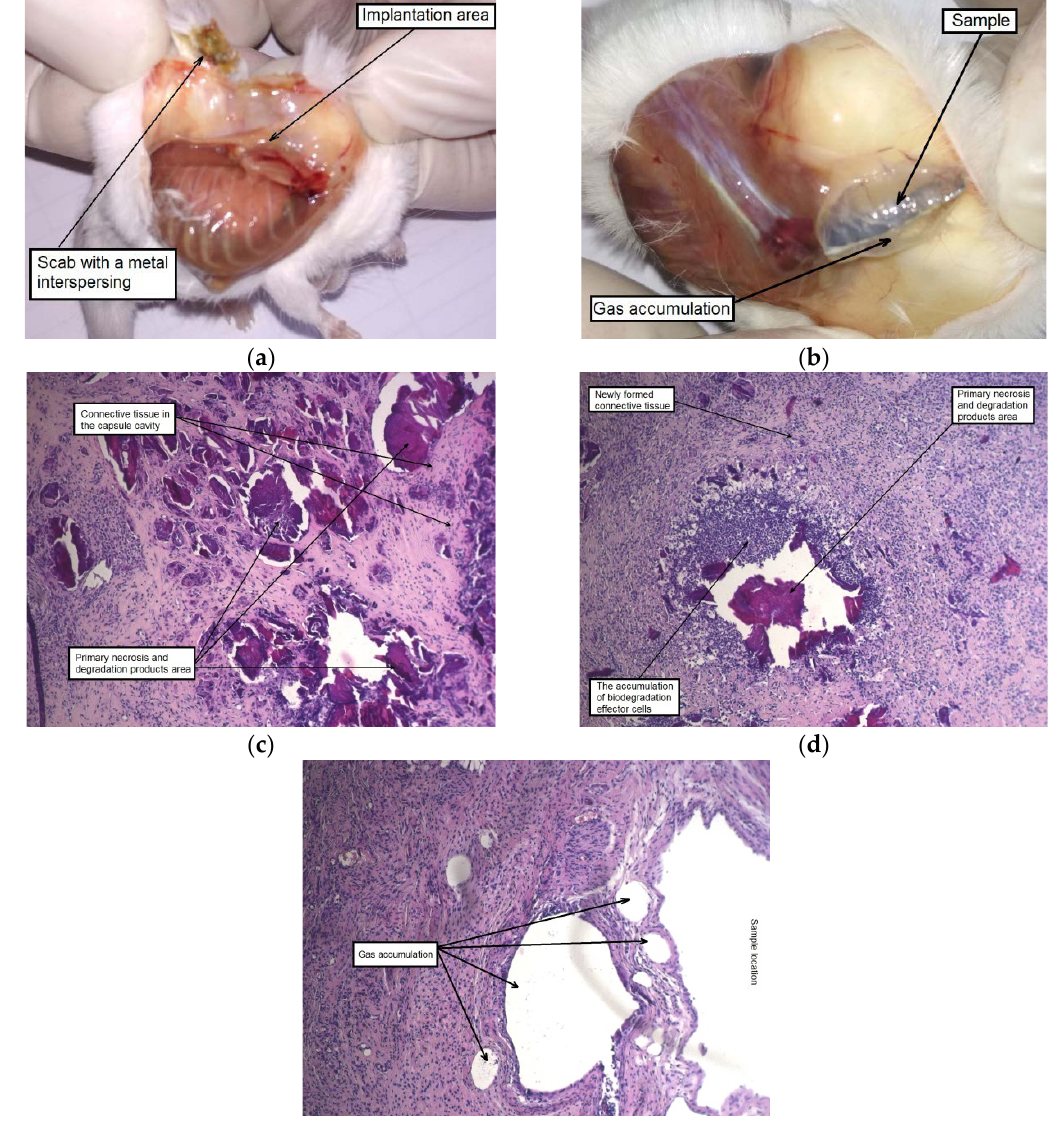
Figure 9. Samples of alloy WE43 and tissues of the implantation area six weeks after surgery: complete degradation of the sample in the initial state of the alloy, a small amount of biodegradation products of the alloy was found only in the skin scab ( a ); capsule formation around the sample in the UFG state of the alloy and gas accumulation in its cavity ( b ); the results of histological examination of mouse tissues (HE staining) in the area of contact with the samples in the initial ( c , d ) and the MAD-processed ( e ) states of the alloy.